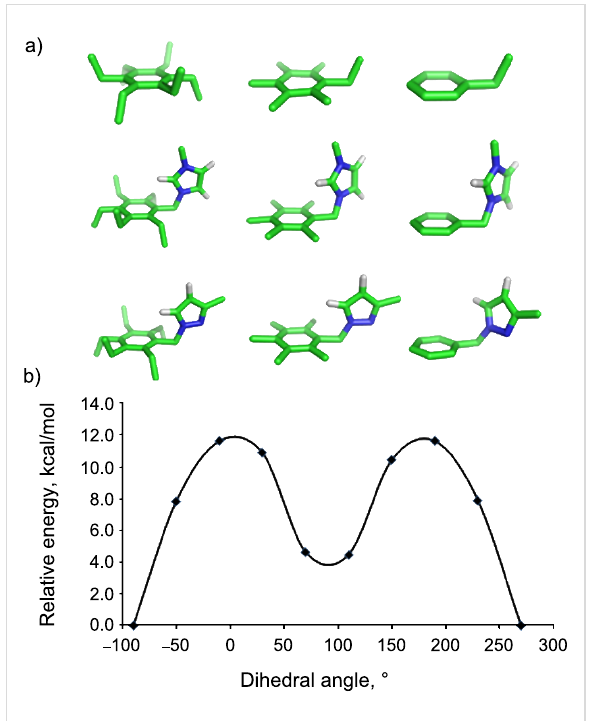
Figure 4: a) Structures used to calculate energy profiles at the starting geometry. b) An example of an energy profile arising from dihedral driving calculations on 1 Et . The smoothed line is intended to guide the reader’s eye.